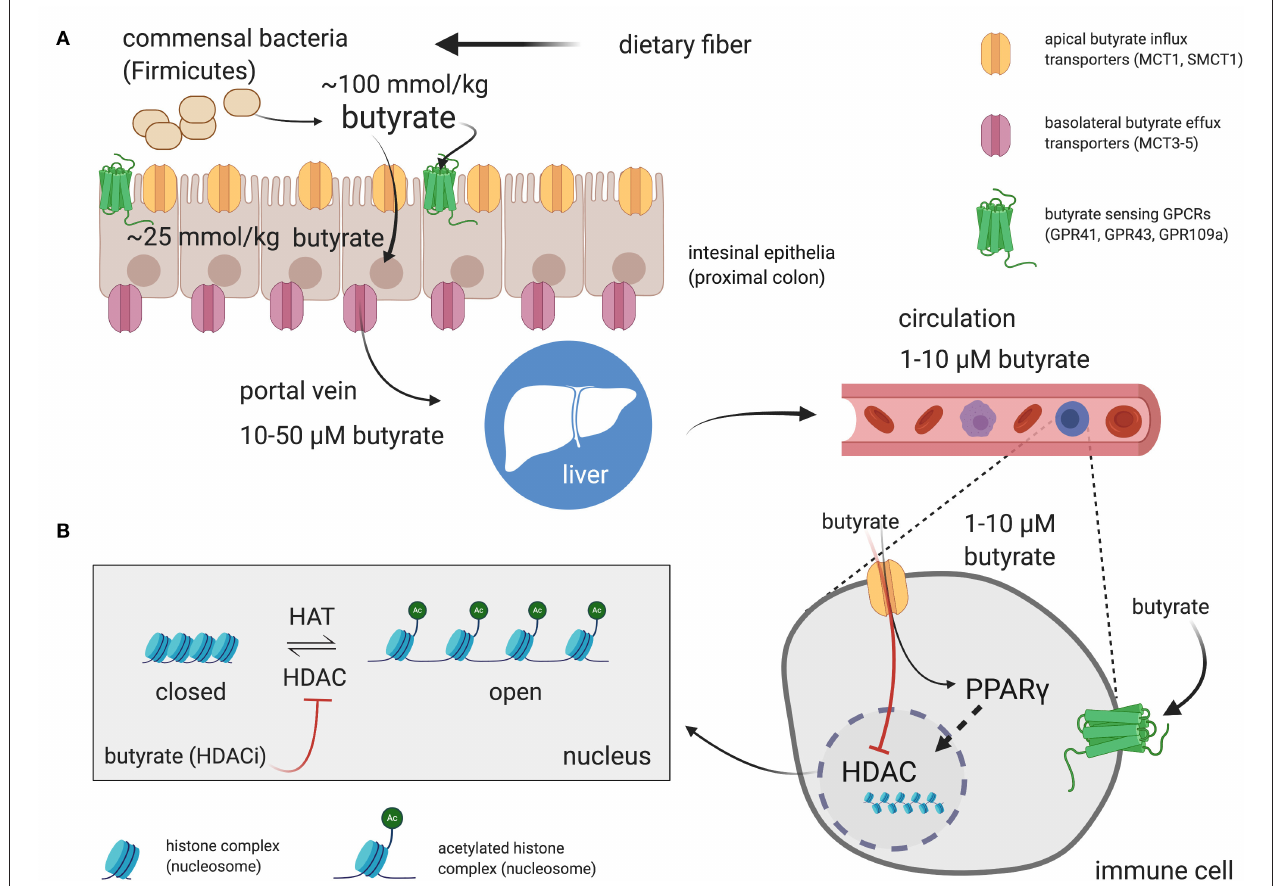
FIGURE 2 | Butyrate production in the intestinal lumen, absorption in the gut, and peripheral distribution. (A) Butyrate is produced from the fermentation of dietary fiber by commensal bacteria (mainly Firmicutes phylum) in the gut lumen. Butyrate can stimulate butyrate-sensitive G protein coupled receptors (GPCRs) expressed on luminal epithelia. However, most of the butyrate is efficiently absorbed by colonocytes through H + - or Na + -coupled monocarboxylate transporters (MCT1 and SMCT1, respectively) expressed on the apical surface of intestinal epithelia. Most of the butyrate is consumed by colonocytes for energy. The remainder is passed through the basolateral membrane into the liver portal system via monocarboxylate transports (MCT3-5). Butyrate then transits to the liver and is absorbed by hepatocytes. Any remaining butyrate not used as an energy source by hepatocytes is then distributed through the circulation to peripheral tissues. The effects of butyrate on immune cells, and most other cell types are mediated through direct activation of surface GPCRs or, following influx into the cell by activation of peroxisome proliferator-activated receptor gamma (PPAR γ ) or inhibition of butyrate-sensitive histone deacetylase (HDAC) isoforms. (B) Most of the reported effects of butyrate on immune cells discussed in the review are dependent on HDAC inhibitory activity of butyrate. Side chain lysine in histone complexes (nucleosomes) in condensed, closed, chromatin are acetylated by histone acetyltransferases (HATs) to provide access for transcription machinery. HDACs remove acetyl groups from histone lysines to promote chromatin condensation and, in general, attenuate gene transcription at targeted loci. Butyrate is the most potent “endogenous” HDAC inhibitor (HDACi) and thereby promotes open chromatin and encourages active transcription. The shown concentrations are those reported for butyrate in the indicated compartments in humans. Created with